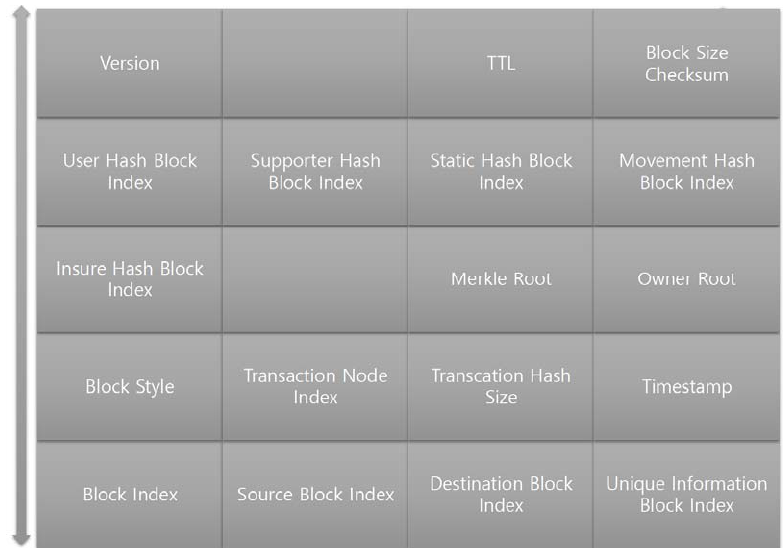
Figure 5. Rainbowchain node. TTL: Talent Tech Lab.